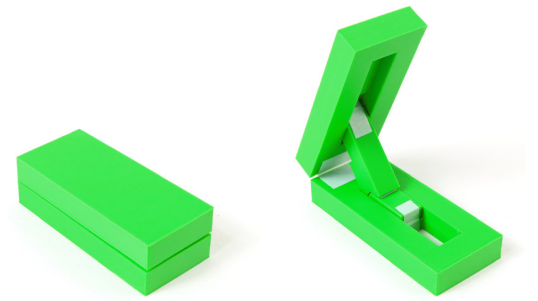
Figure 19. Inverted planar deploying strut ThUDS. Flat foldabil- ity is in the same direction as deployment. Joint offset values are adjusted to increase surface contact. Shown in flat-folded and de- ployed states.